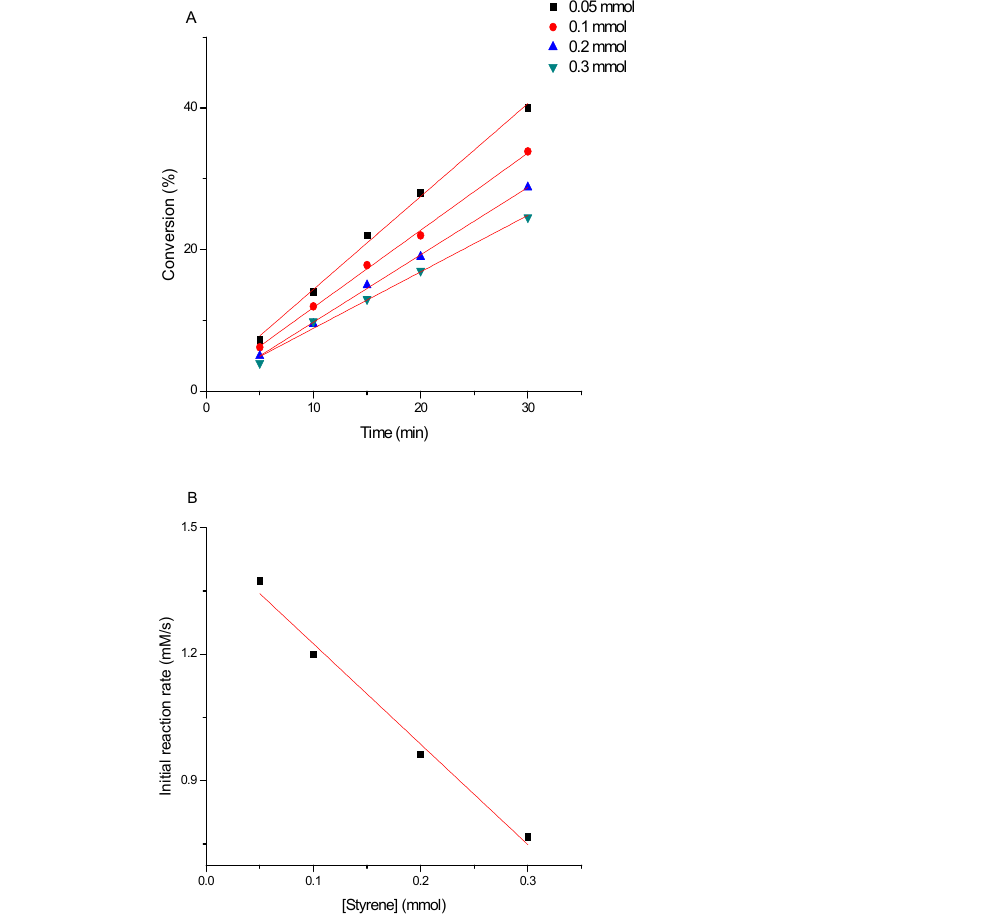
Figure 8. ( A ) Influence of varying styrene concentration with time; ( B ) plot of initial reaction rate vs styrene concentration. Reaction conditions: T = 80 °C; [catalyst] = 0.002 mmol; [H 2 O 2 ] = 1 mmol; [acetonitrile] = 3 mL.